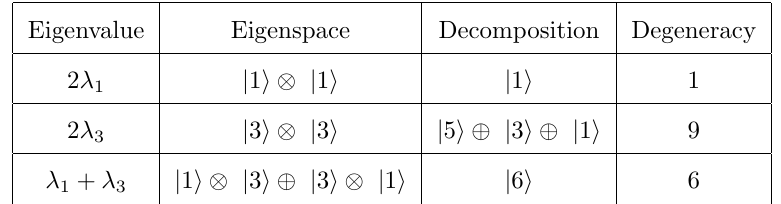
Table 5 . Analysis of the spectrum of the D 2